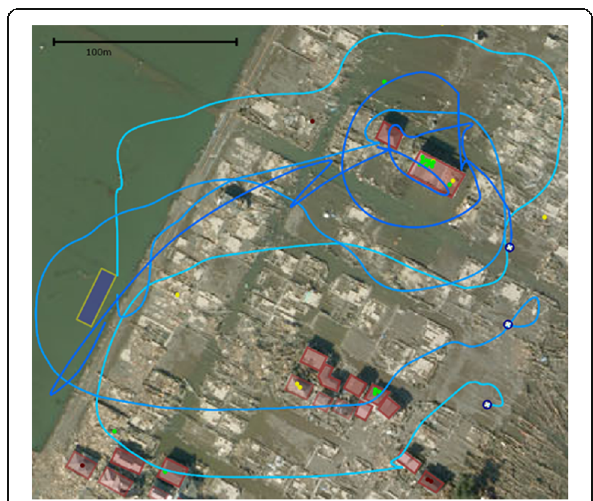
Fig. 5 Spiral method showing the paths of three UAVs. As with standard method, UAVs launched from the blue rectangle. Note the circular pattern in the northeast corner as a UAV located the group of survivors (green dots) on top of the elevated building and performed the spiral behavior while the others continued the search. Photograph by GSI of Japan (Geospatial Information Authority of Japan